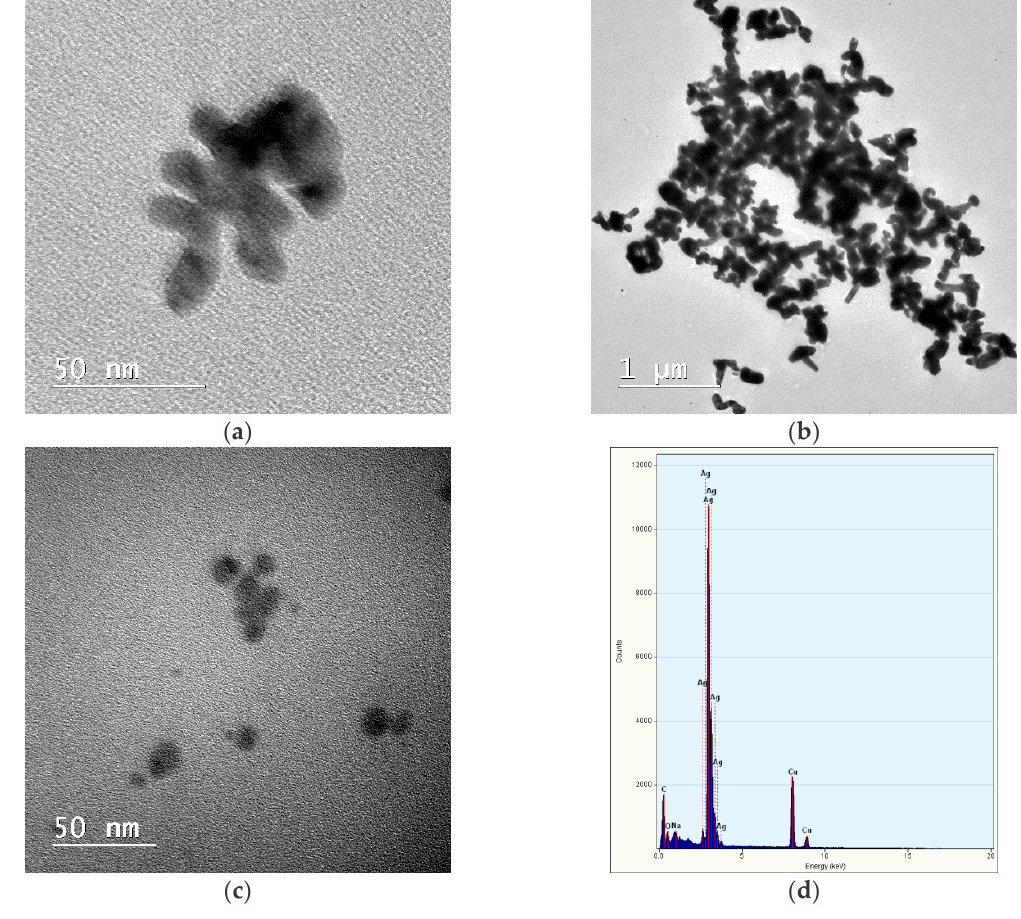
Figure 2. TEM images of AgNPs prepared in distilled water without stabilizer ( a ), with 0.05% chitosan as stabilizer ( b ) and ( c ), and energy dispersive spectroscopy (EDAX) for the AgNP sample with chitosan ( d ).